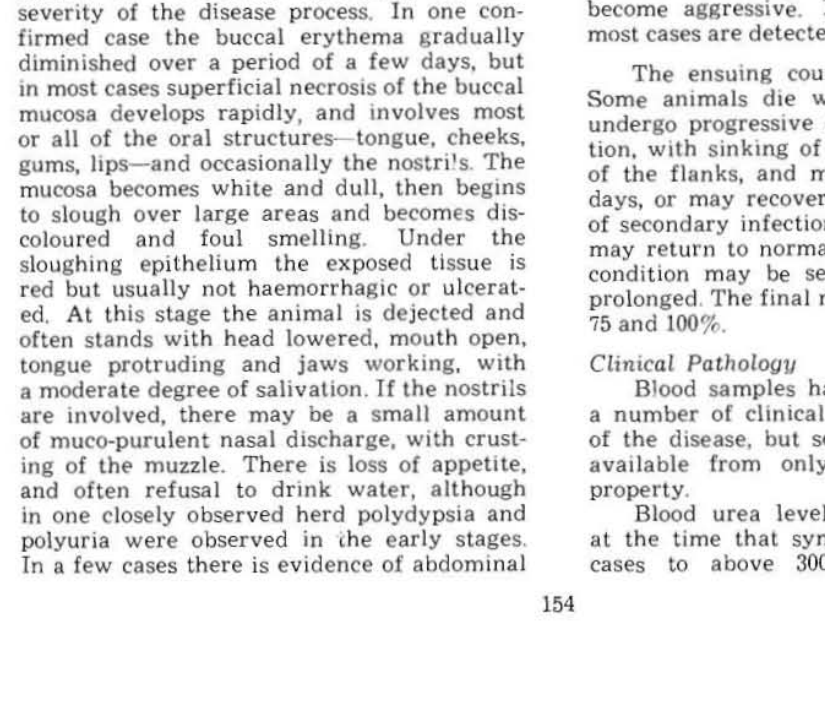
Pig. I: Lo ... ·tr J'w. showing severt diphtheritic ltom'titls.. Pig. 2: Pal'lt, showing sevtre stomatitis with circular lesIOns of seconduy fungal Infection. Pig. 3: section of buccal epithelium, showlnll superhcla\ necrosis. 1'1 & E. FIll". 4: Oesophagus. showing longitudinal